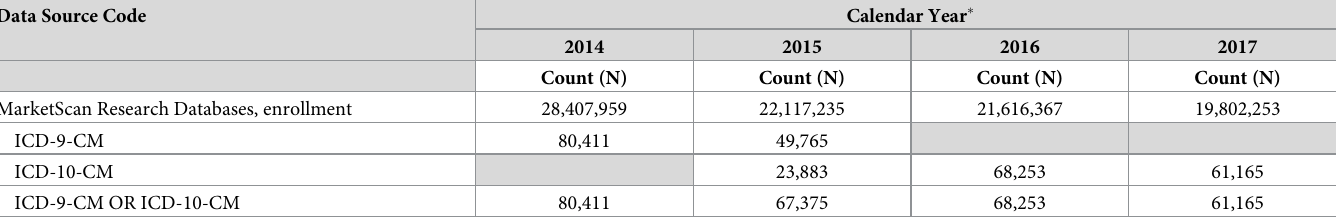
Table 3. Annual counts of individuals enrolled in MarketScan Research Databases and counts of patients with � 1 AMI diagnosis according to ICD-CM codes received in any healthcare setting (2014–2017).